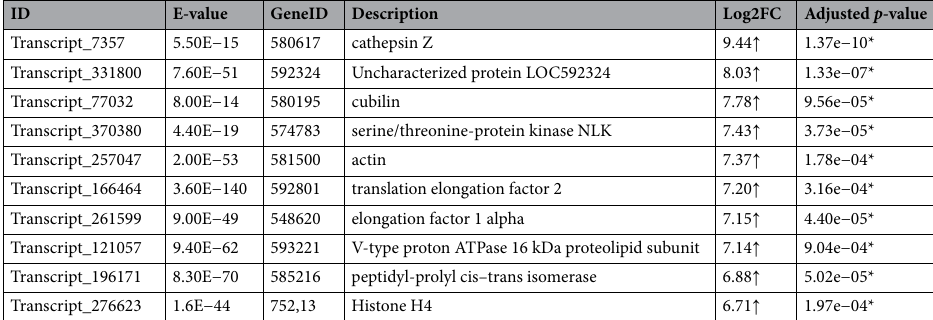
Table 1. Top 10 upregulated DEGs at day 1 of regeneration. ↑ : Upregulated (Log2FC > 2); *: Significant ( p value < 0.01); Log2FC: Log 2 Fold Change.